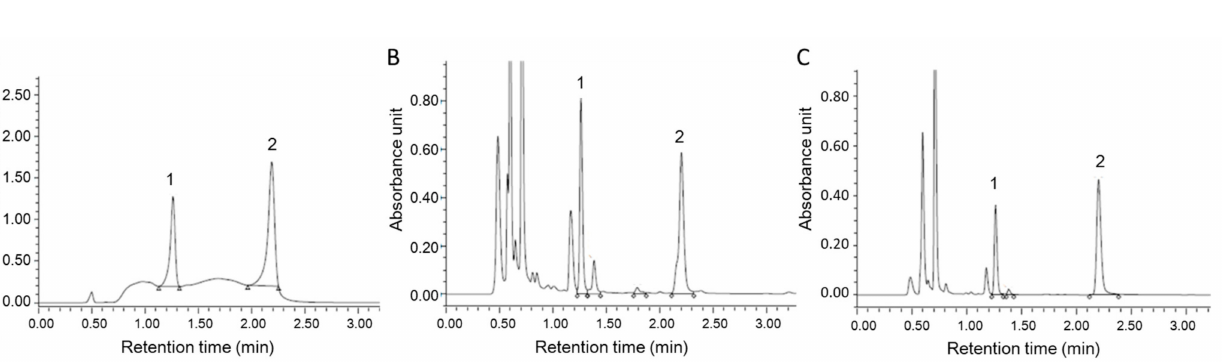
Figure 5. UPLC chromatograms of ( A ) standards, ( B ) extracts from miso and ( C ) extracts from PFM monitored by UV (260 nm). Peak 1: Daidzein; peak 2: